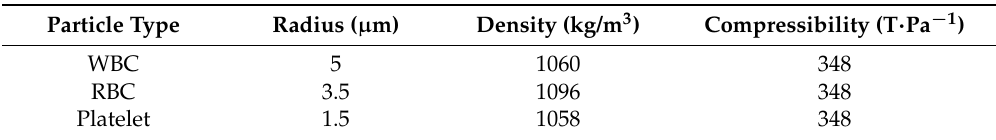
Table 2. The values of radius, density, and compressibility for WBCs, RBCs, and